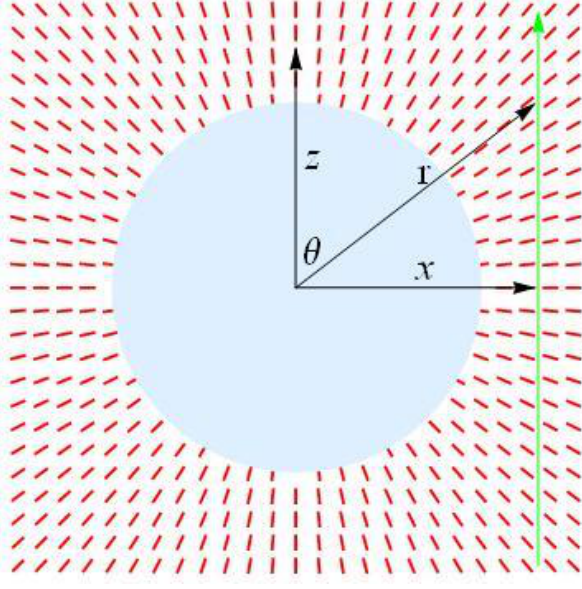
Figure 15. Light propagation (vertical green arrow on the right hand side) in a medium with radial configuration of the optic axis (red bars) around the wire (grey